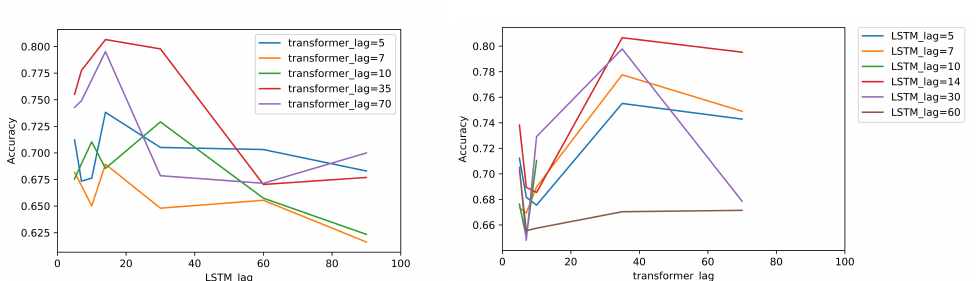
Figure 6. Parameter analysis results in different lags. The figure on the left shows LSTM lag windows’ influence on the accuracy. In addition, the right figure shows transformer lags’ impact on the